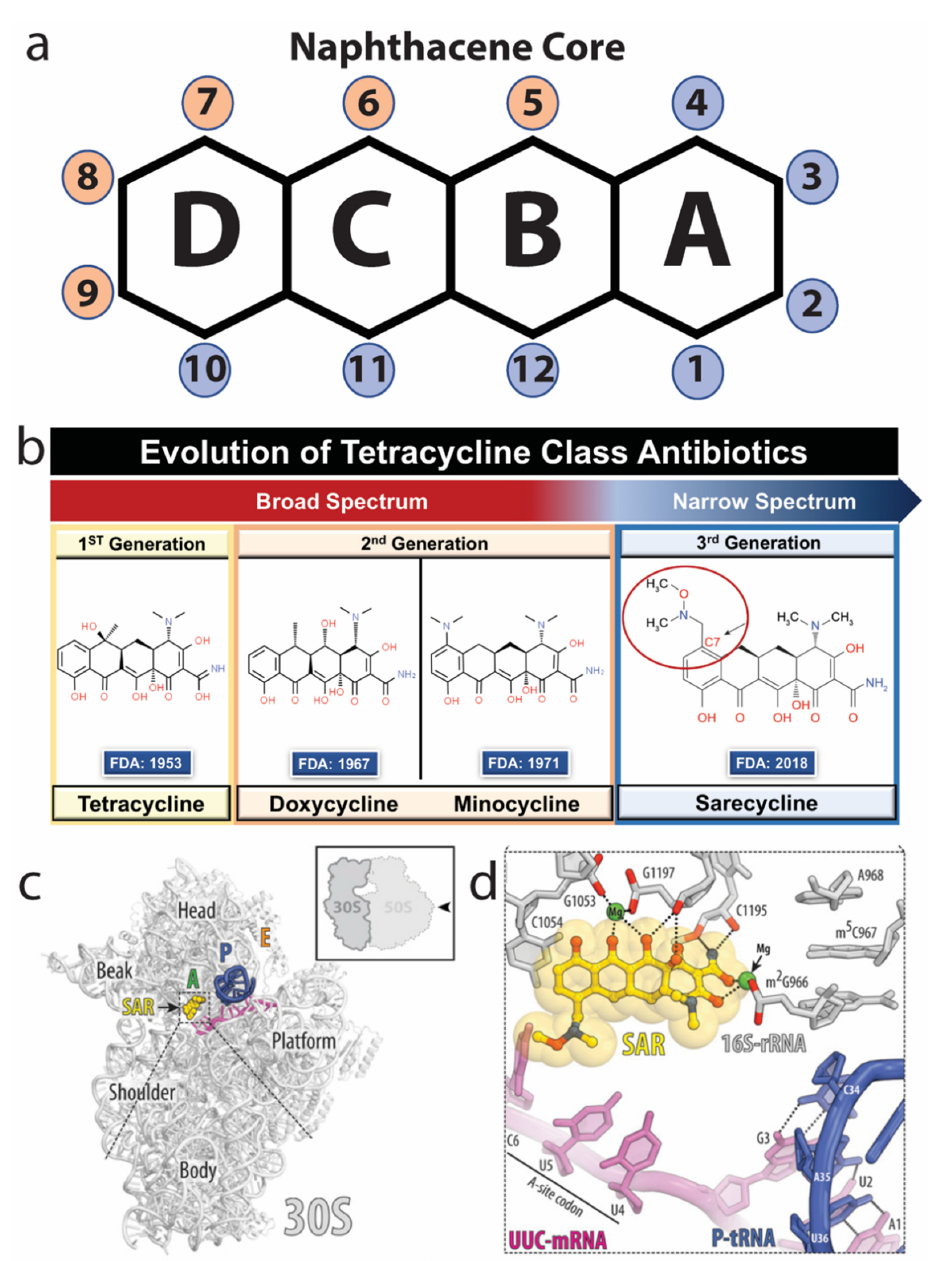
Figure 2. Evolution of chemical and structural properties of tetracyclines over 65 years. ( a ) The four rings of the naphthacene core, the building block of tetracycline antibiotics, are designated “A” through “D”. Carbon positions along the four-ring core are numbered 1–12, with 1–4 and 10–12 colored blue and 5–9 colored orange. The carbon positions colored blue represent the hydrophilic surface of the antibiotic that forms hydrogen bond interactions with the phosphate-oxygen atoms of the 16S rRNA of the bacterial ribosome. The carbon positions colored orange represent the hy- drophobic surface that is amenable to chemical modifications without loss of inhibitory activity.